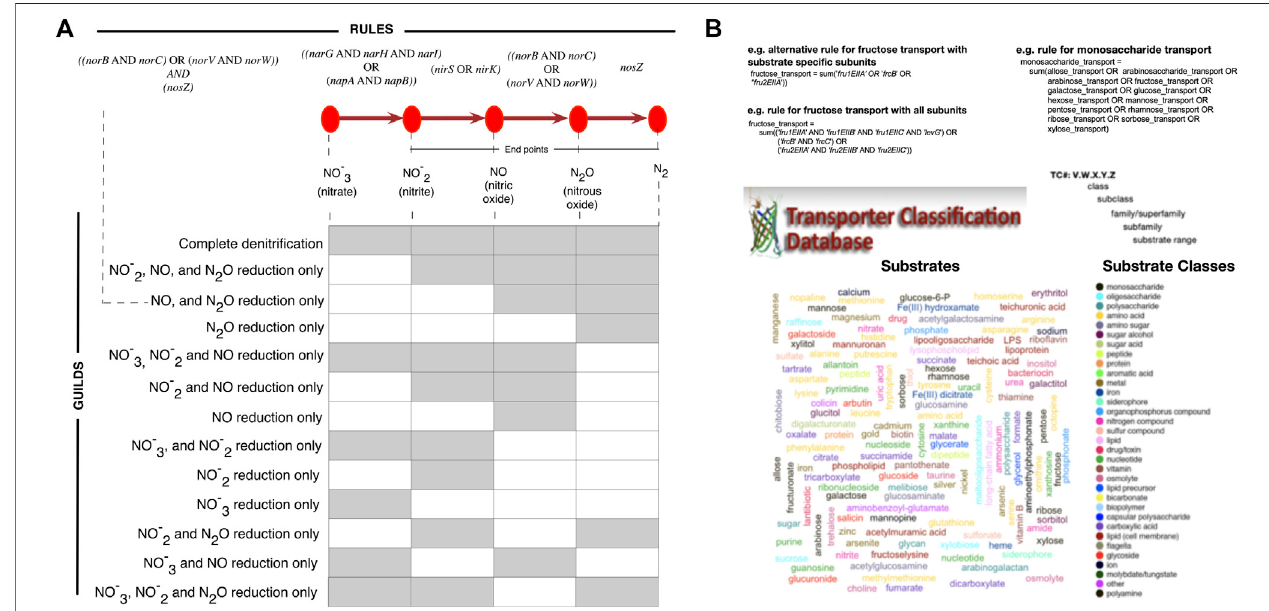
FIGURE 3 | Trait inference with microTrait rules. microTrait rules use simple boolean logic to map presence/absence of microTrait -HMMs (italicized) to traits. The recon fi gurability of the rules makes the exploration of the effect of different trait de fi nitions on the microbial guilds possible and therefore enables a fl exible microbial trait extractionpipeline.Examplesfortraitde fi nitionsfromrulesfor (A) denitri fi cationtraits.Rule-basedinferenceallows fl exiblede fi nitionoftraits,forexamplebyendproducts of denitri fi cation. (B) substrate uptake. microTrait represents substrate uptake traits using the range substrates documented in TCDB (Transported Classi fi cation Database) (shown as word cloud colored by substrate class). Traits relevant to the uptake of substrates (example for monosaccharides) can be de fi ned in a hierarchical manner with rules de fi ned from other rules and microTrait